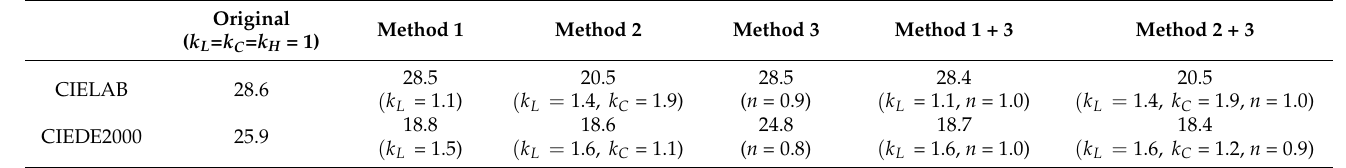
Table 3. The STRESS values and corresponding optimized parametric factors for CIELAB and CIEDE2000 formulas, considering the visual results from Experiment I.